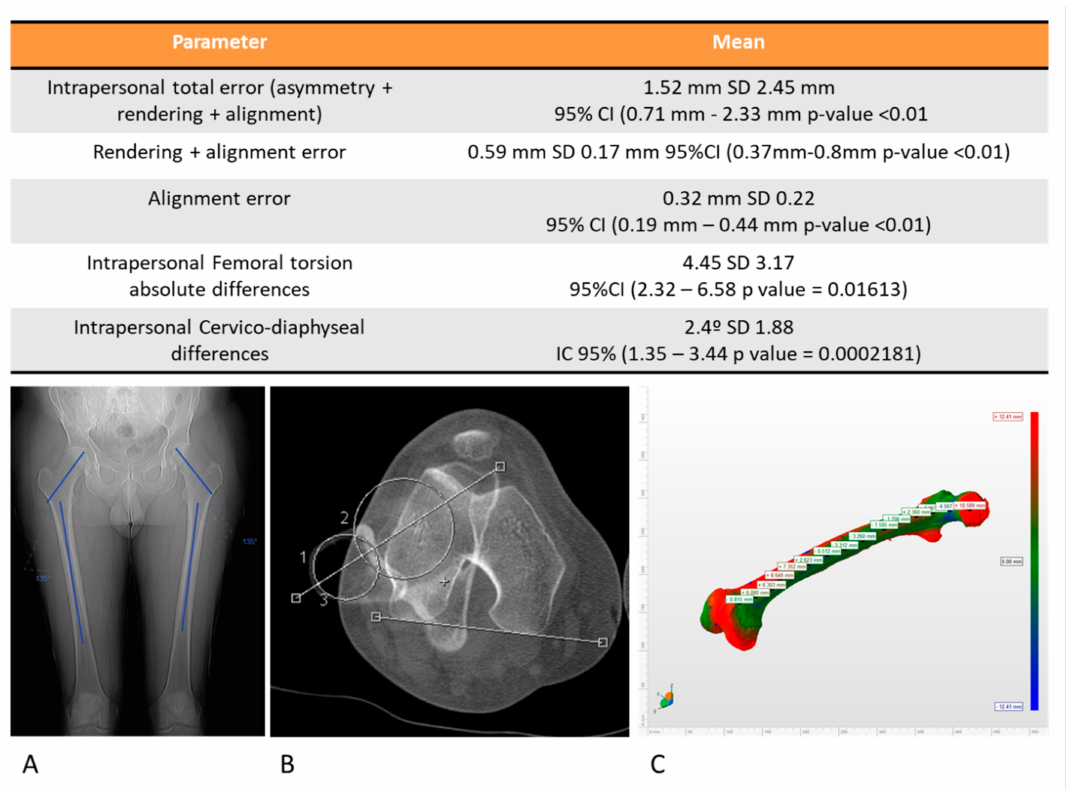
Figure 3. Average and maximum error in the alignment step ( A ); average and maximum error in millimeters in the rendering step ( B ).